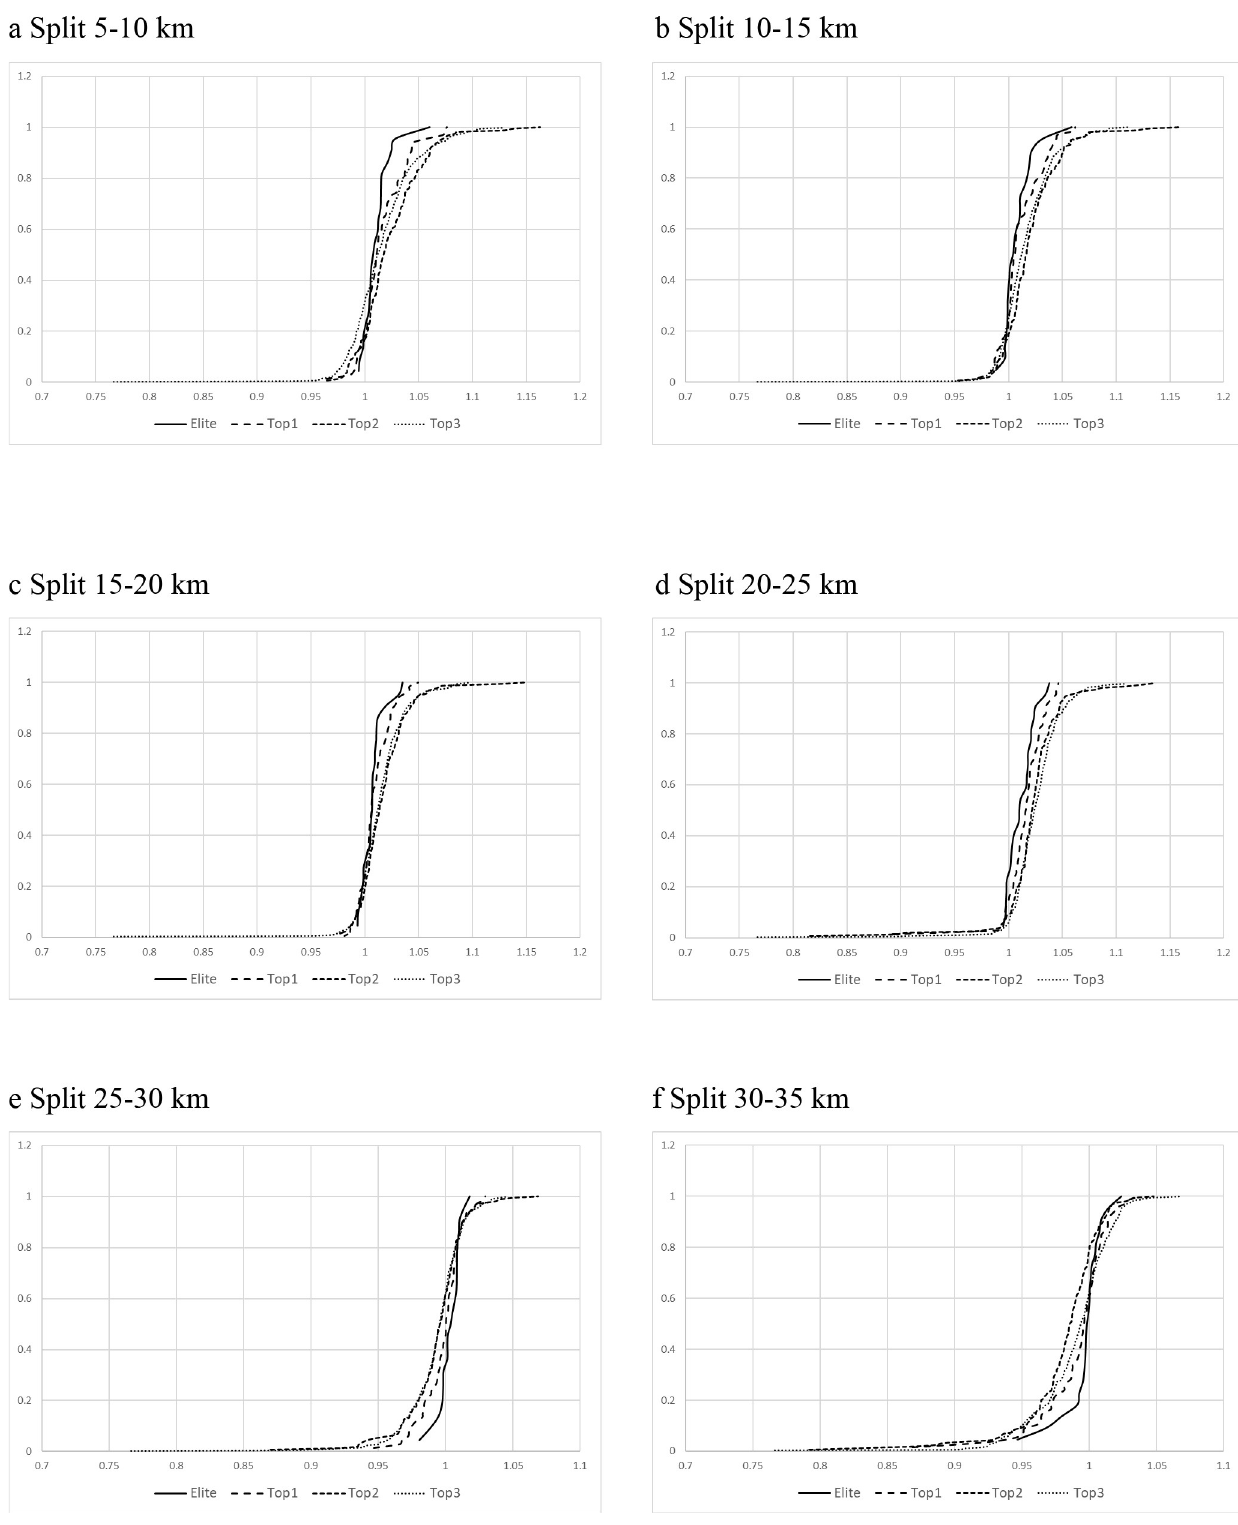
Fig 4. Competition profile of the female athletes in splits with significant differences between groups. “X” axis: standardized velocity; “Y” axis: relative frequency. A standardized velocity of "1" represent the mean velocity of the athletes in the marathon.